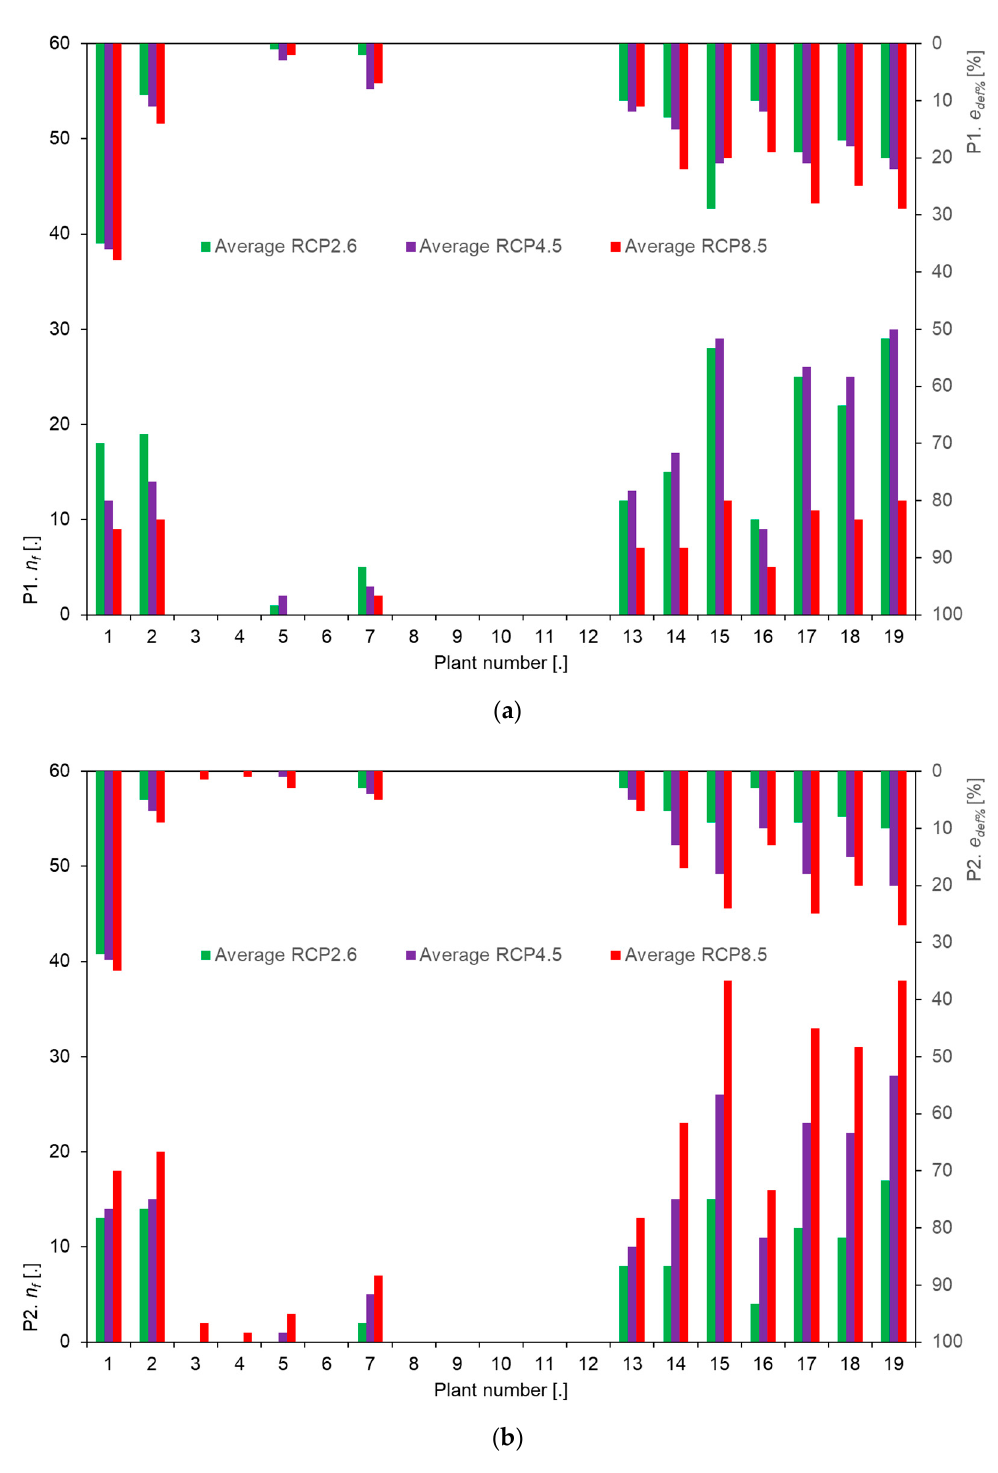
Figure 9. Designed grid. Average (three GCMs) projected number of failure days n f (left y axis) and maximum percentage energy deficit e def% (right y axis, values upside down) for each RCP. ( a ) P1 . ( b ) P2 .